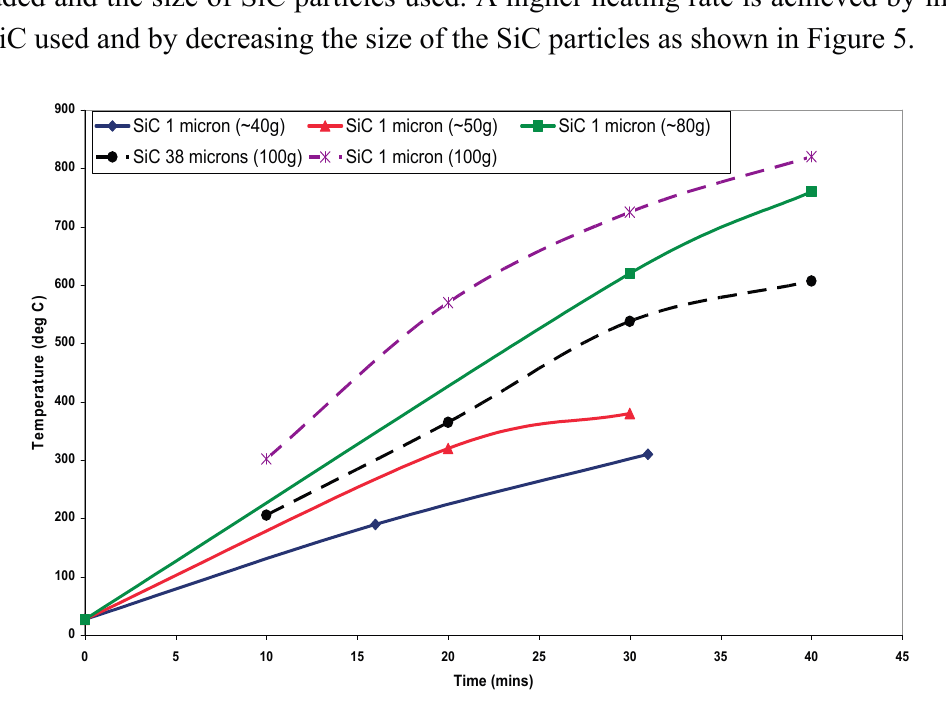
Figure 5. Effect of amount and particle size of SiC susceptor on the heating rate